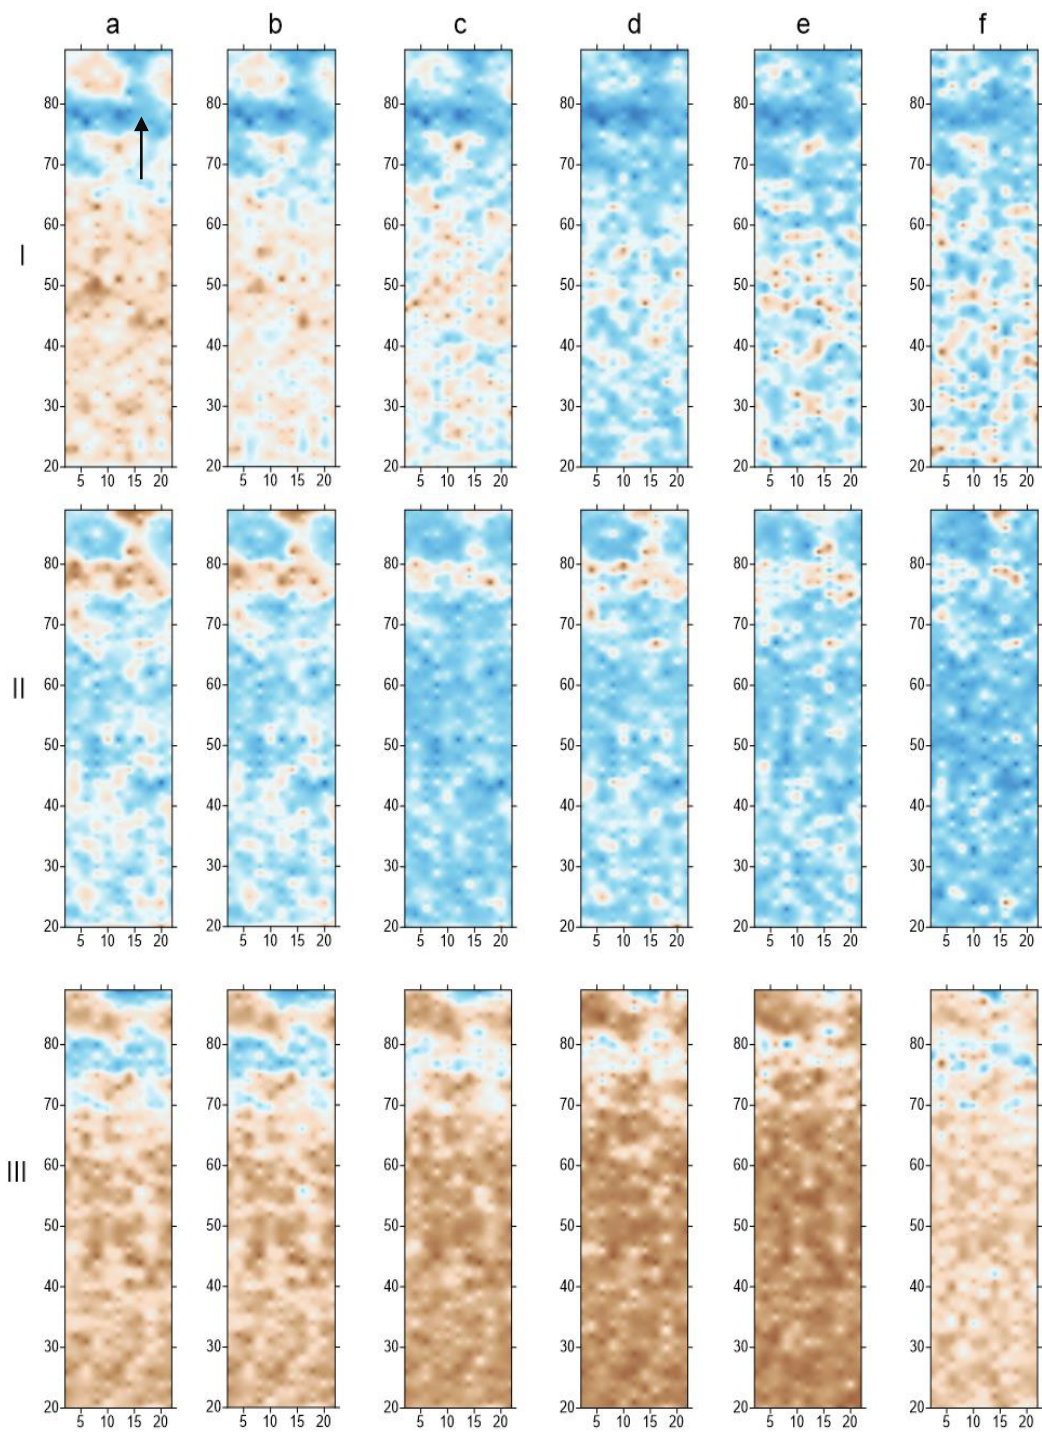
Figure 5. Column a : Raw GPR data; Column b : GPR data with random noise of level 0.1 of the standard normal distribution; Column c : GPR data with random noise of level 0.2 of the standard normal distribution; Column d : GPR data with random noise of level 0.3 of the standard normal distribution; Column e : GPR data with random noise of level 0.4 of the standard normal distribution; Column f : GPR data with random noise of level 0.5 of the standard normal distribution. Row I : Depth slice of 0.00–0.20 m below ground surface; Row II: Depth slice of 0.20–0.40 m below ground surface and Row III: Depth slice of 0.40–0.60 m below ground surface.